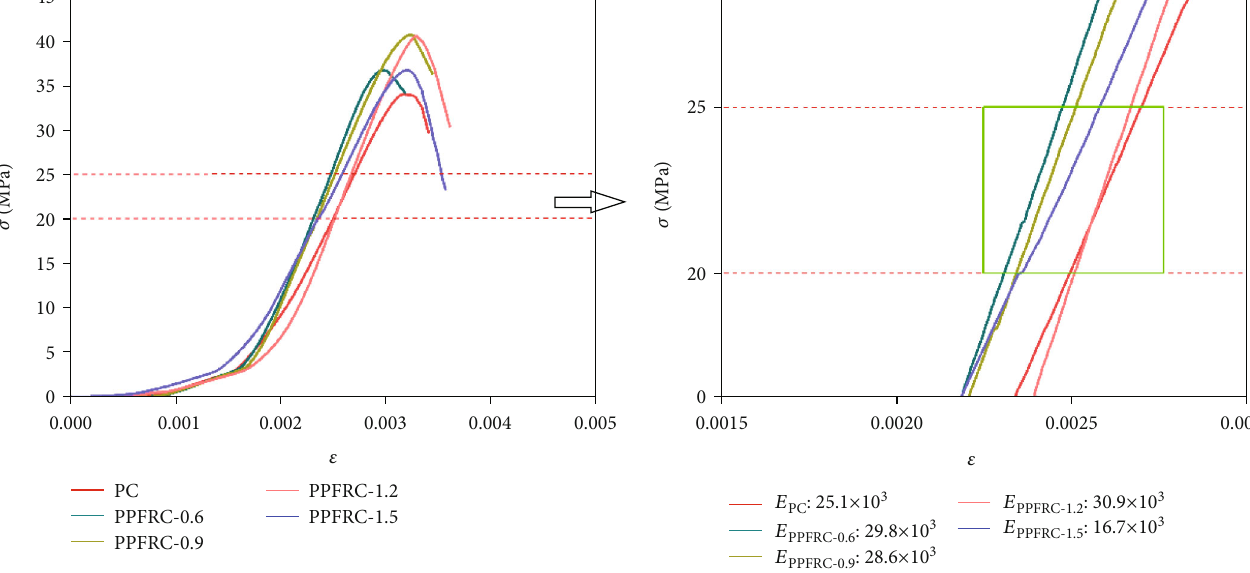
Figure 20: Uniaxial compressive stress-strain curve of PC and PPFRC at 60-day curing